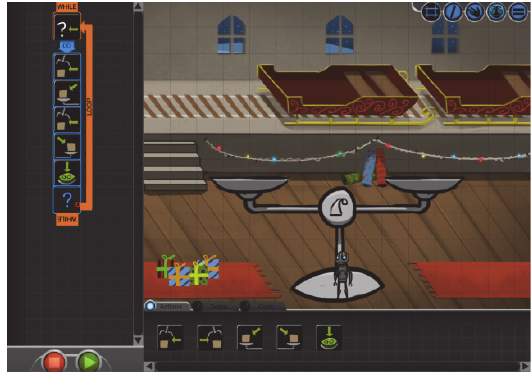
Figure 2 . The Santa Claus puzzle in the cMinds learning environment [13]